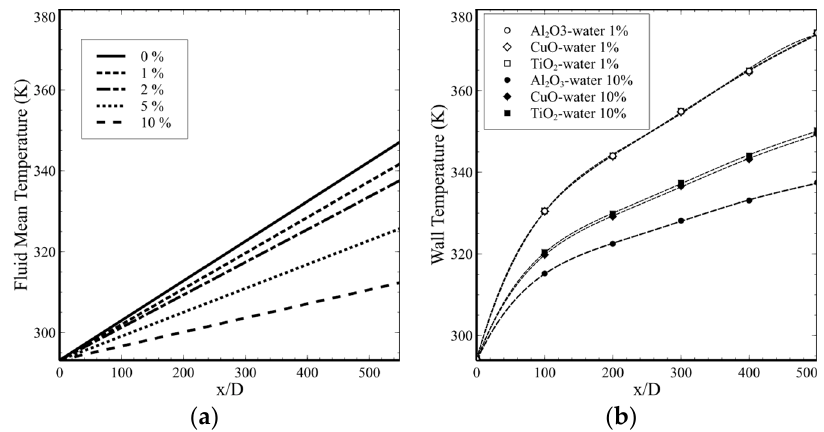
Figure 3. Effect of nanoparticle concentration in tube flow: ( a ) axial development of T m ; ( b ) axial development of wall temperatures.